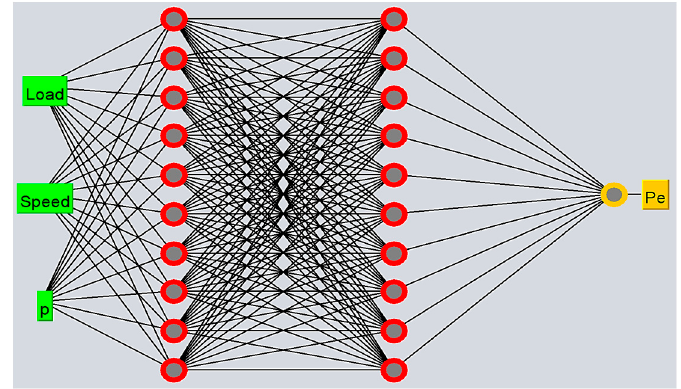
Figure 14. The [3 × 10 × 10 × 1] architecture chosen for the edge AI compact ANN.